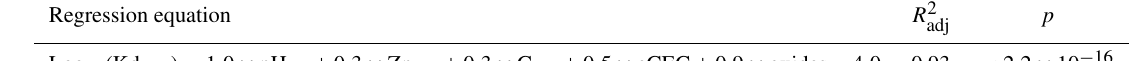
Table 2. Regression equations for Log 10 (Kd Lab ). Regression equation